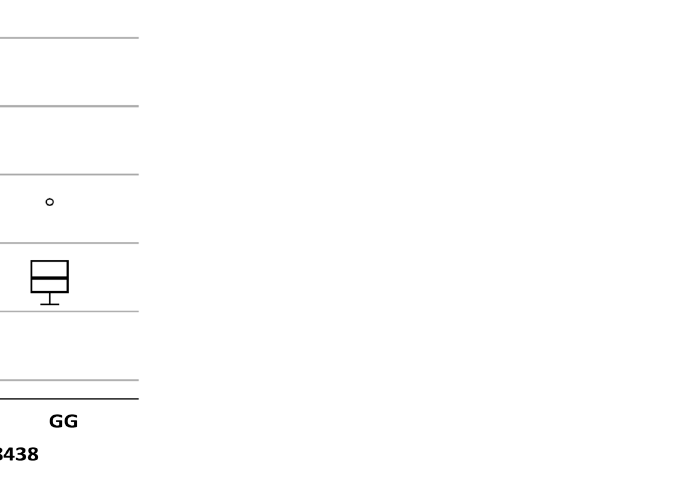
Figure 2. Heatmap matrix of pairwise linkage disequilibrium statistics.